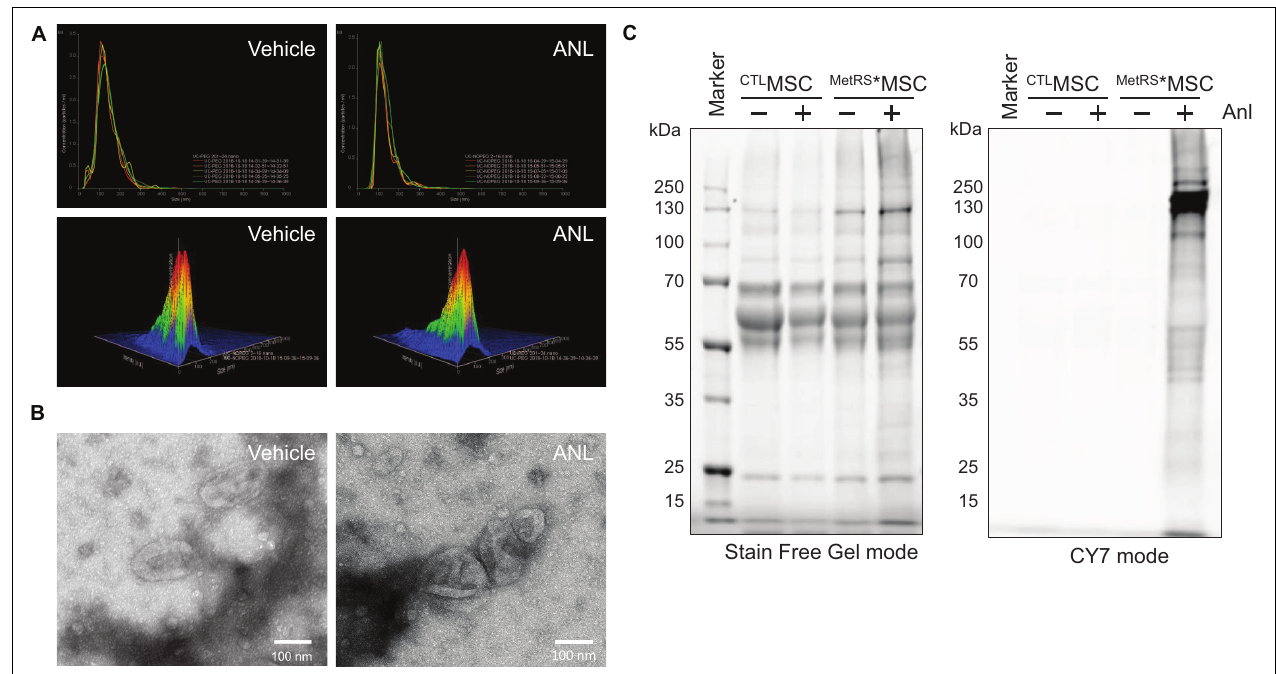
FIGURE 2 | Exosomal proteins from ANL-treated MetRS ∗ MSCs can be detected via alkyne-Cy7 click-staining. (A,B) The MetRS ∗ MSCs were incubated with ANL (+) or vehicle (–) for 24 h; then, exosomes were isolated from culture media and evaluated via (A) nanoparticle-tracking analysis and (B) transmission electron microscopy (TEM). (C) Exosomes were isolated from CTL MSCs and MetRS ∗ MSCs that had been incubated with ANL (+) or vehicle (–) for 24 h; then, the exosomes were lysed, and proteins were separated on an SDS-PAGE gel, click-stained with alkyne-Cy7, and imaged in stain-free and Cy7 mode (BONCAT).